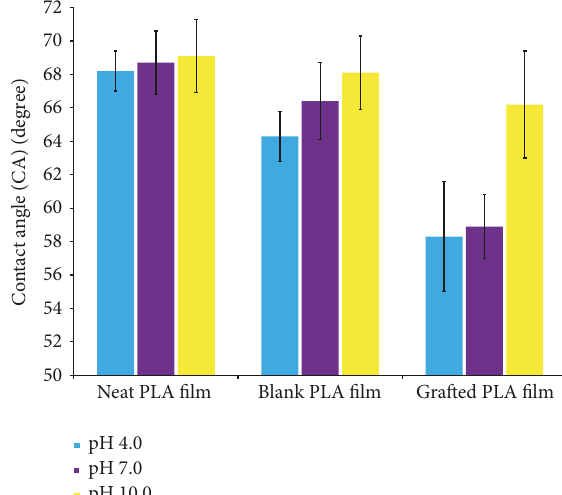
Figure 6: Contact angle (CA) values of neat, blank, and grafted PLA films, measured by using water droplets at various pH values. Figure7:XRDdiffractogramsofneat(i),blank(ii),andgraftedPLA